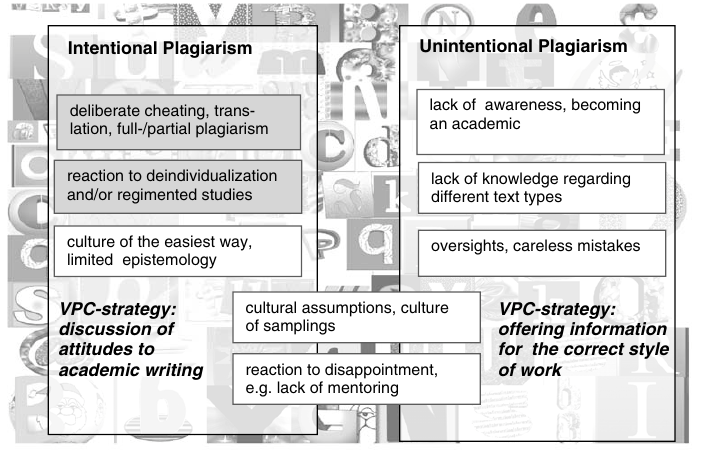
Figure 1. Possible reasons for